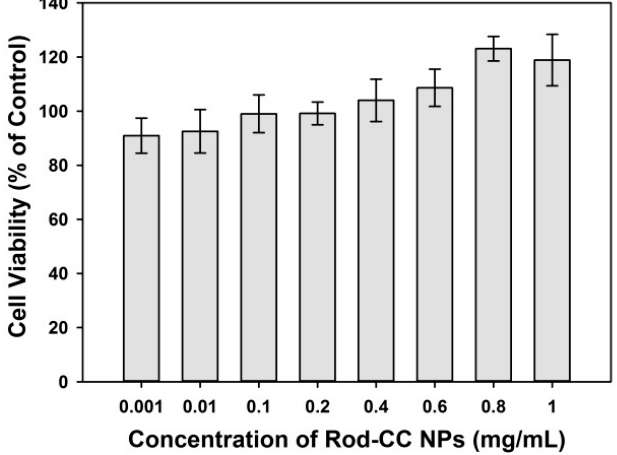
Figure 6. Cell viabilities of MC3T3-E1 cells treated with different concentrations of Rod-CC NPs for 48 h.